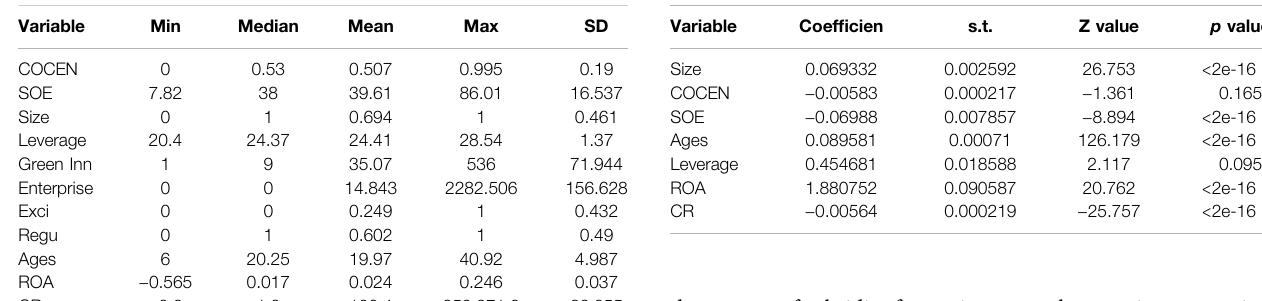
TABLE 4 | PSM Logit regression results about